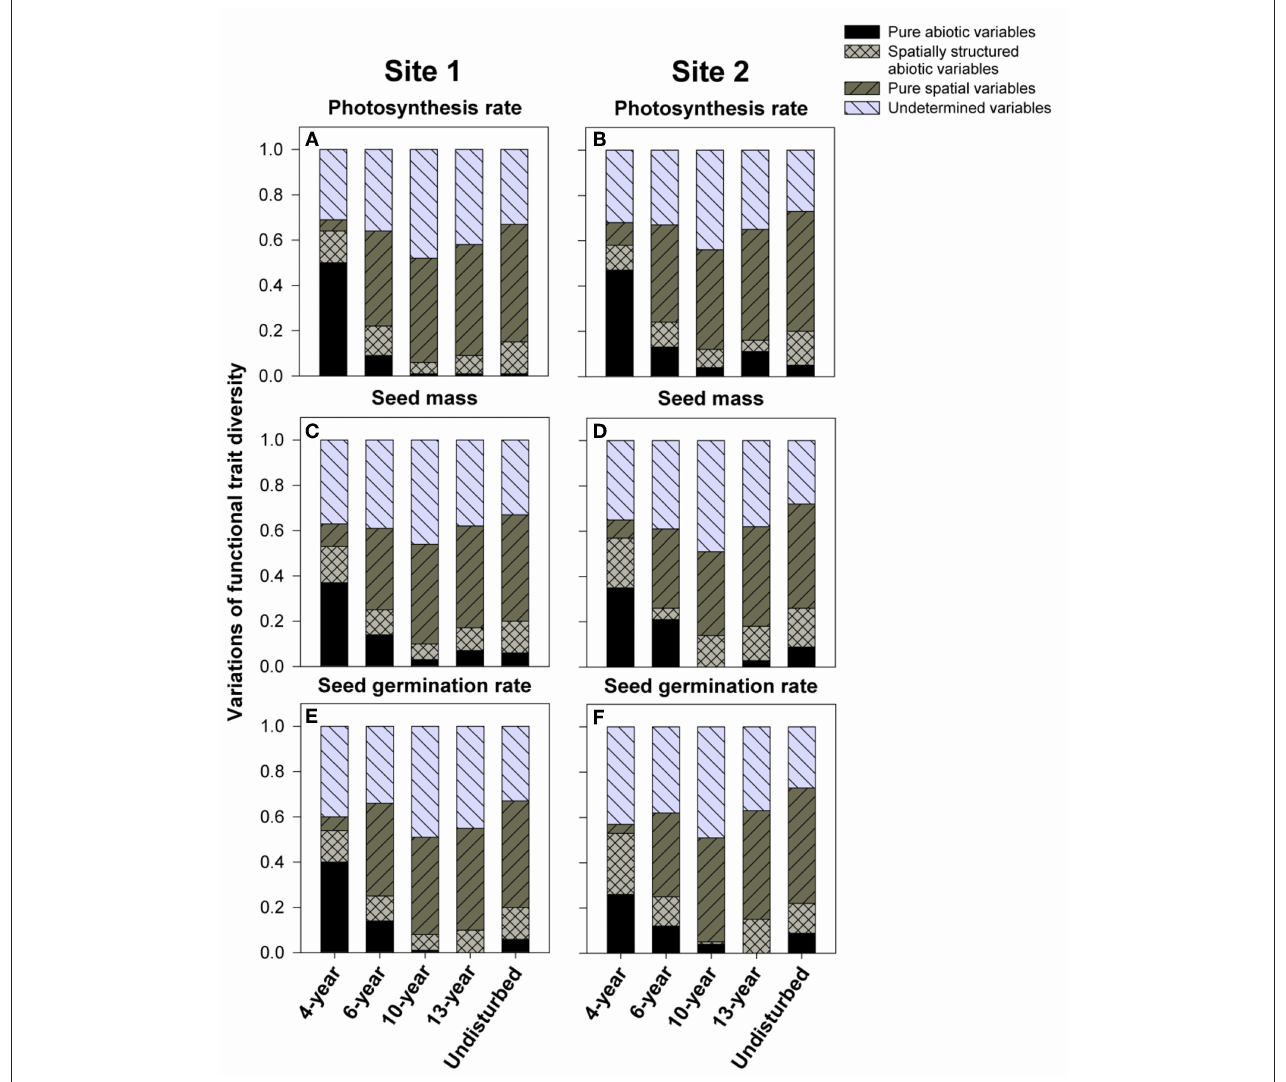
FIGURE 5 | Variance partitioning analyses of the distributions of functional trait diversity with successional age. Variations explained by purely abiotic, spatially structured abiotic, purely spatial, or undetermined variables are shown if statistically significant ( p < 0.05). Each analysis was performed on all quadrants within the successional grasslands. (A,C,E) Represent variations of FD for photosynthesis rate, seed mass, and seed germination rate in chronosequence 1, respectively. Likewise, (B,D,F) indicate variations of FD for photosynthesis rate, seed mass, and seed germination rate in chronosequence 2